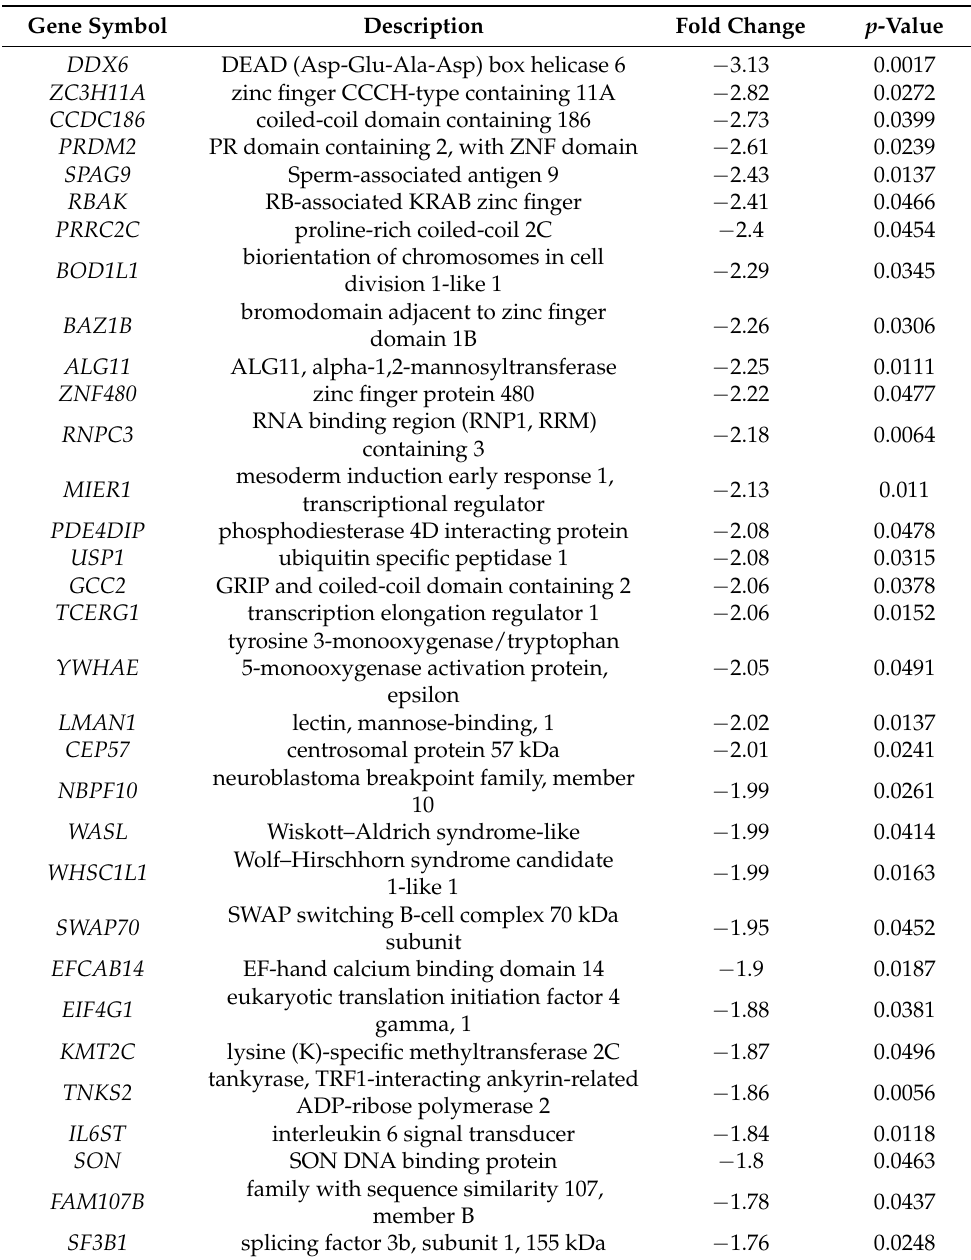
Table 2. List of downregulated genes with fold change > 1.3 compared to control